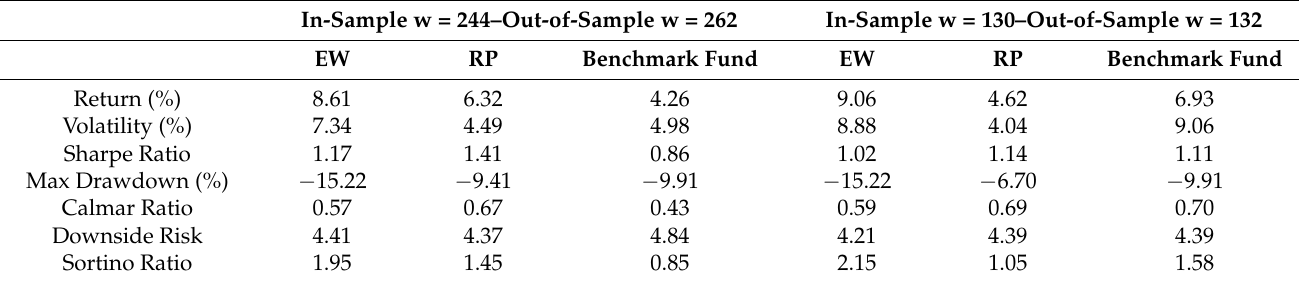
Table 5. The performance of the Conventional